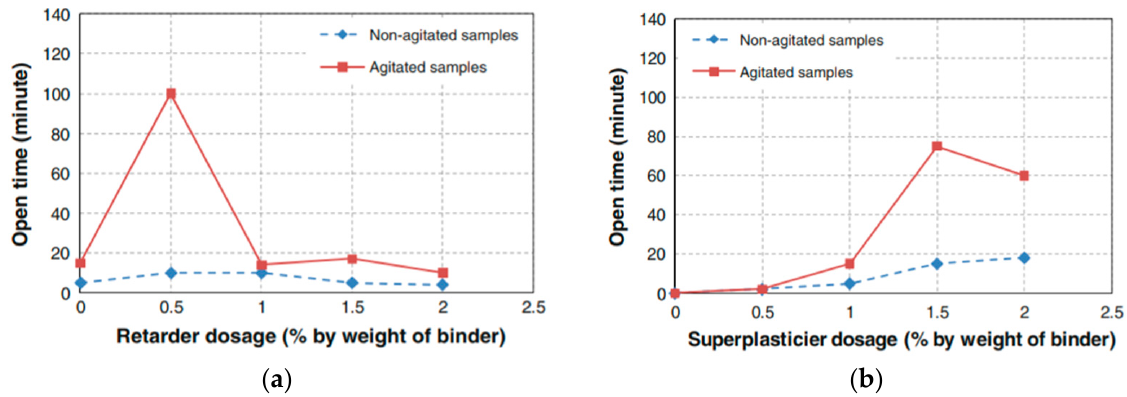
Figure 7. ( a ) Retarder dosage versus open time. ( b ) Superplasticiser dosage versus open time. Reprinted with permission from ref. [16]. Copyright 2012, The setting time test is based on different standards, and the instruments and meth ‐ ods used by the researchers are not the same. Chen et al. [37] started printing a strip of